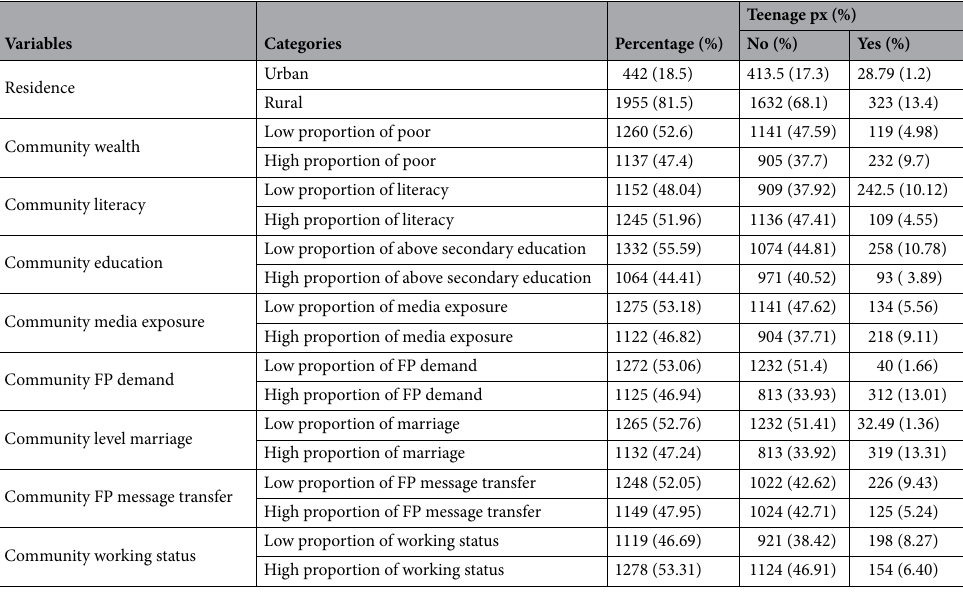
Table 2. Community level characteristics and teenage pregnancy distribution (n = 2397), Ethiopia 2016. Px : pregnancy, FP : family planning.